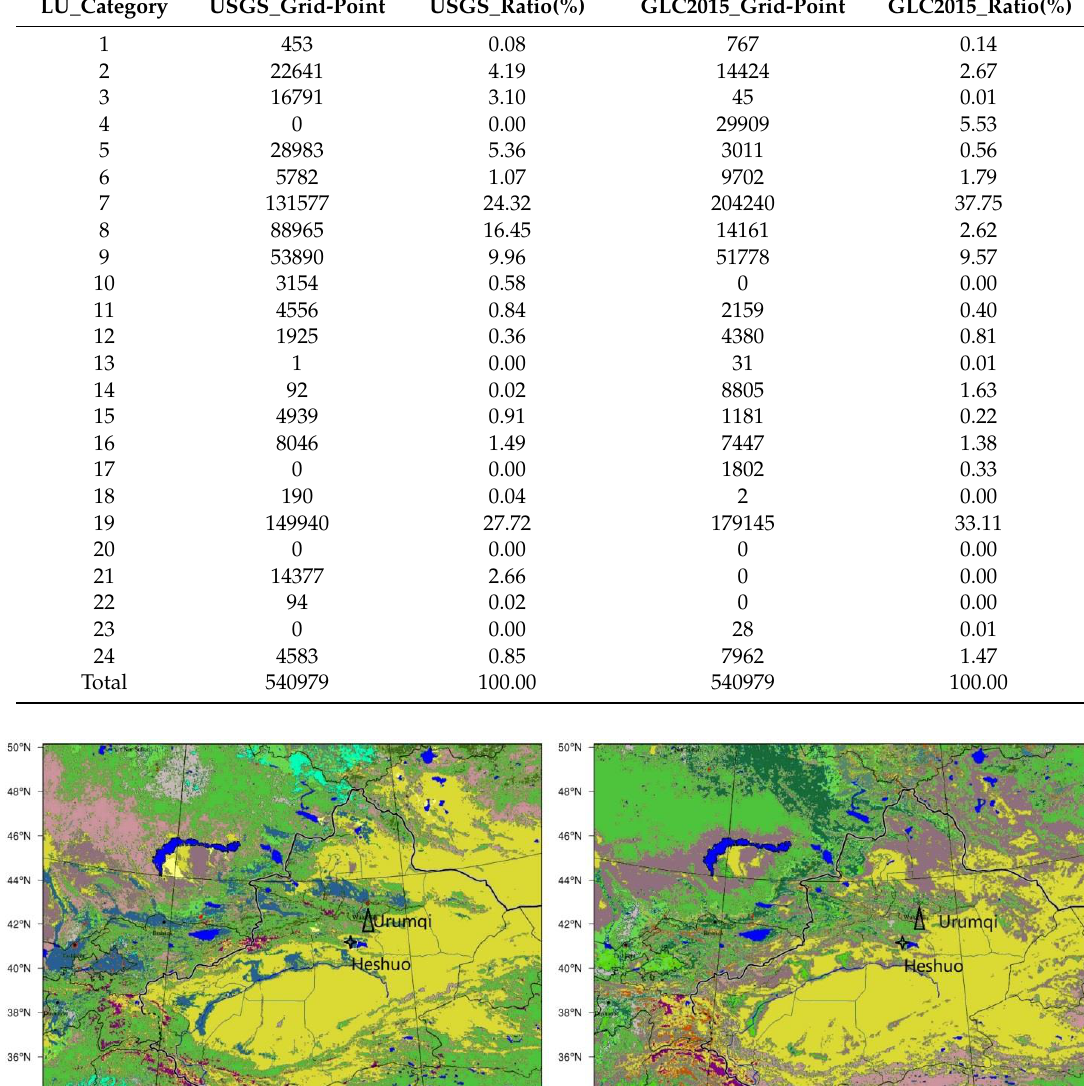
Table 2. Land-use type statistic and percentage changes of GLC2015 and USGS.